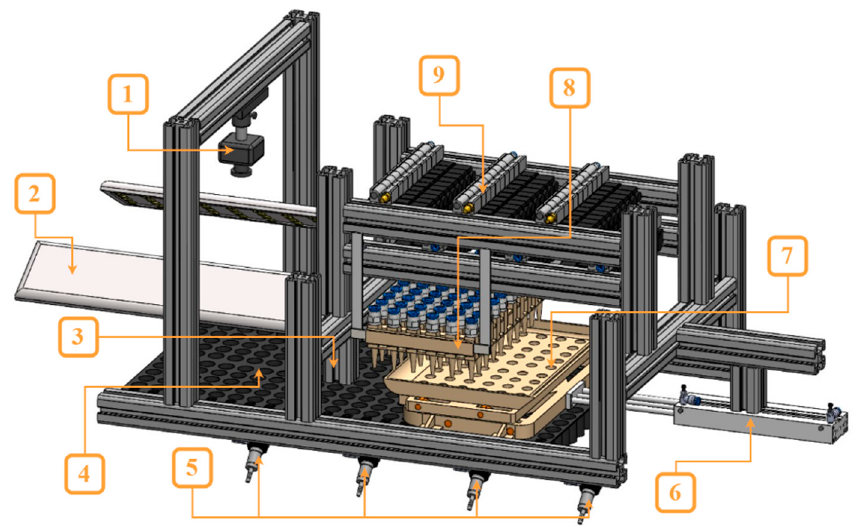
Figure 3. Pneumatic complementary seeding device. The pneumatic complementary seeding device hardware system consists of the following: 1. industrial camera, 2. light panel, 3. limiters, 4. tray, 5. photoelectric sensors a–d, 6. pneumatic cylinder, 7. liftable sliding seed case, 8. seed suction nozzle array, and 9. air source control device.